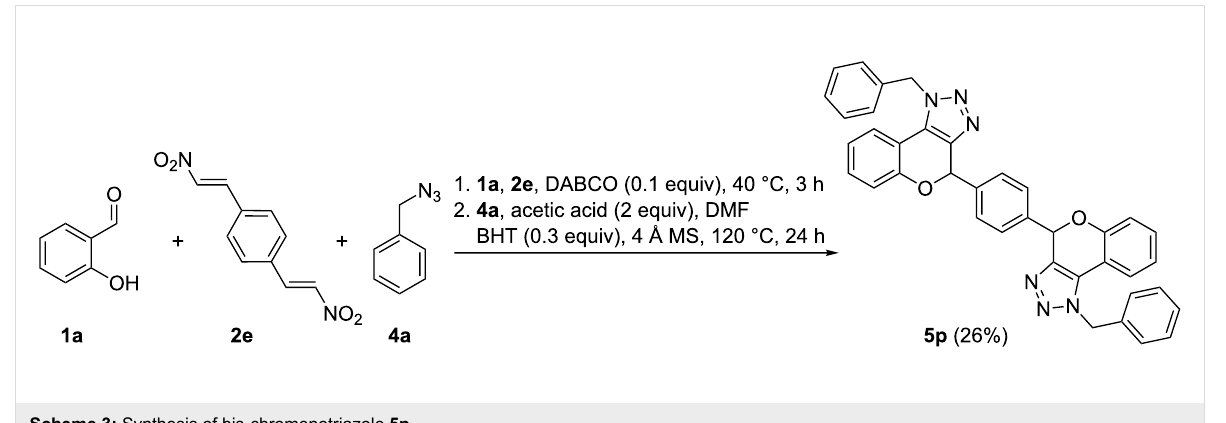
Scheme 3: Synthesis of bis-chromenotriazole 5p